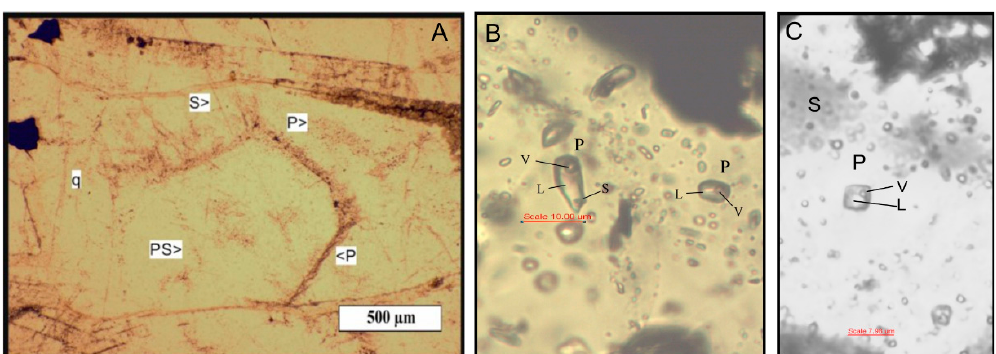
Figure A1. Microphotographs of fluid inclusions from the stratiform ore of Reppia and Corchia as well as from the stockwork ore of Casali–Monte Loreto. A : location of primary (P), secondary (S) and pseudosecondary (PS) inclusions in quartz from Casali–Monte Loreto. B : liquid (L), vapor (V) and accidentally trapped solid (S) containing primary inclusion in quartz from Reppia. C : negative crystal-shaped two-phase inclusion in calcite from Corchia.